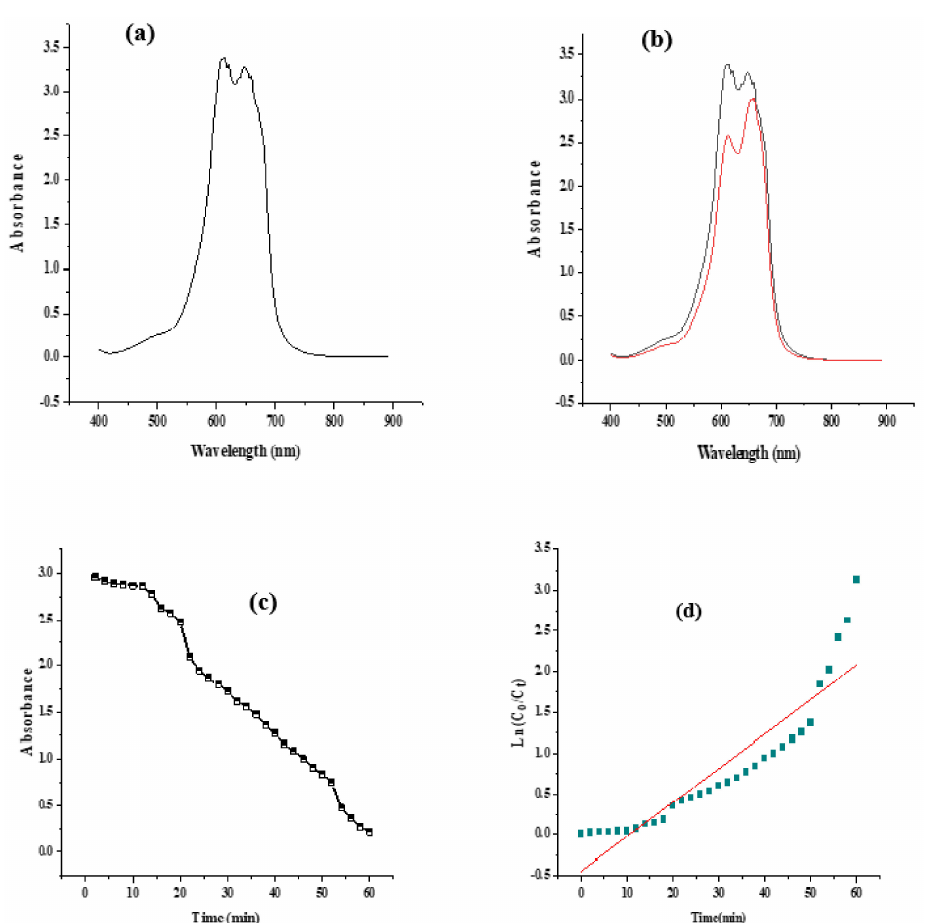
Figure 10. ( a ) UV-Vis spectra of methylene blue solution. ( b ) UV-Vis spectra of methylene blue solution after treatment with NaBH 4 . ( c ) Degradation trend of methylene blue monitored for an hour with regular intervals of 2 min showing decrease in absorbance, time-dependent kinetically plotted graph ( d